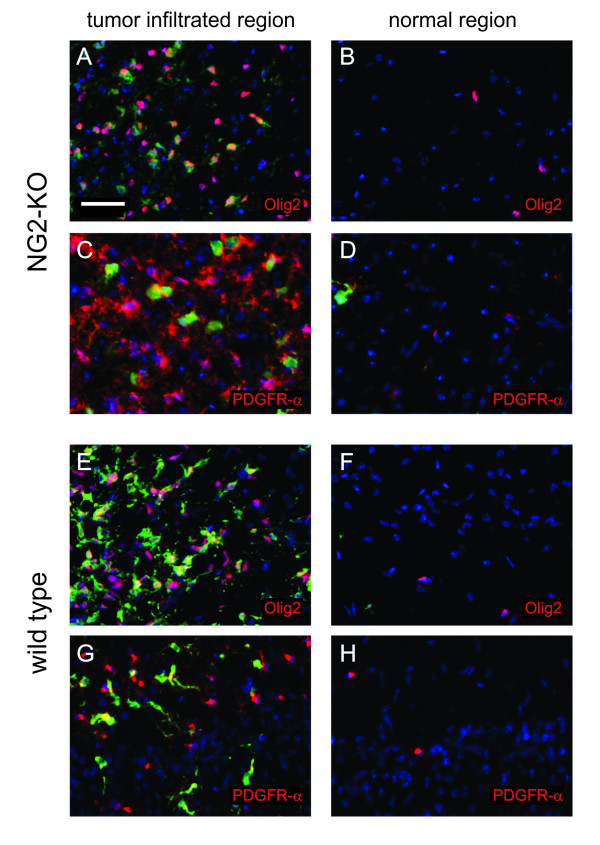
PDGF-B-induced tumors recruit OPCs also in the absence of NG2 expression. (A-H) Immunofluorescence stainings of NG2-KO (A-D) and wild type (E-H) glioma sections with anti-GFP antibody in green, DAPI for nuclear staining in blue and antibodies for the indicated antigens in red. The left column of the figure corresponds to tumor infiltrated regions, while pictures on the right represent normal brain regions next to tumor areas showing the basal level of OPC markers expression for comparison. Scale bars: 50 μm